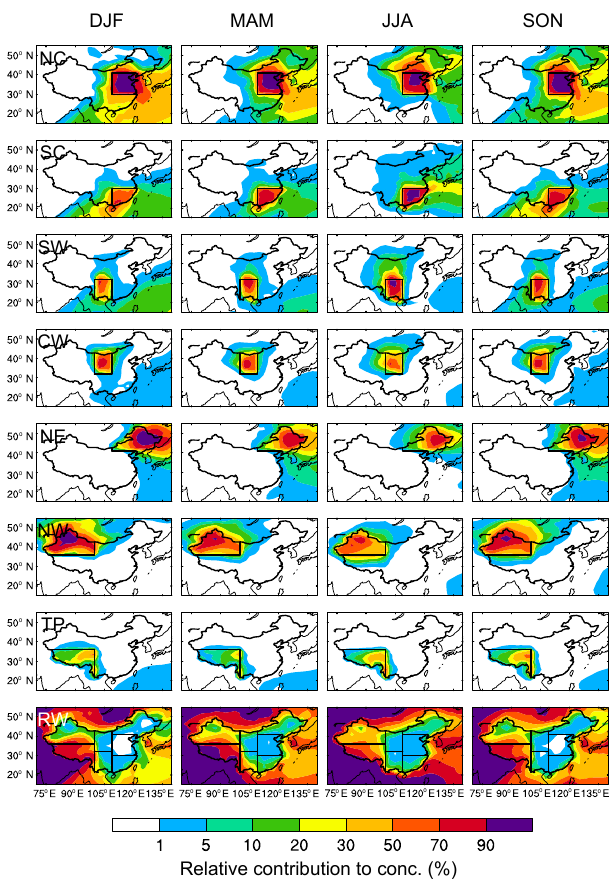
Relative contribution to conc. (%) Figure 6. Spatial distribution of relative contributions (%) to sea- sonal mean near-surface BC concentrations from each of the tagged source regions.